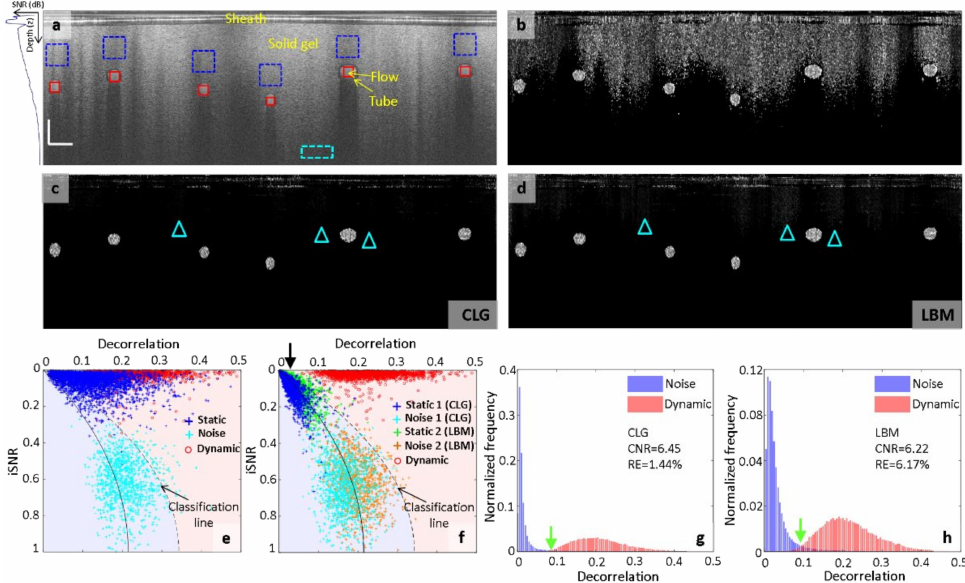
Figure 3. Validation of the correction effect of the distortion through flow phantom experiment imaging with endoscopic clinical proximal scanner. ( a ) Cross-sectional structure of flow phantom. Left inset is the averaged depth profile indicating the SNR decay. The mean iSNR and SNR of the